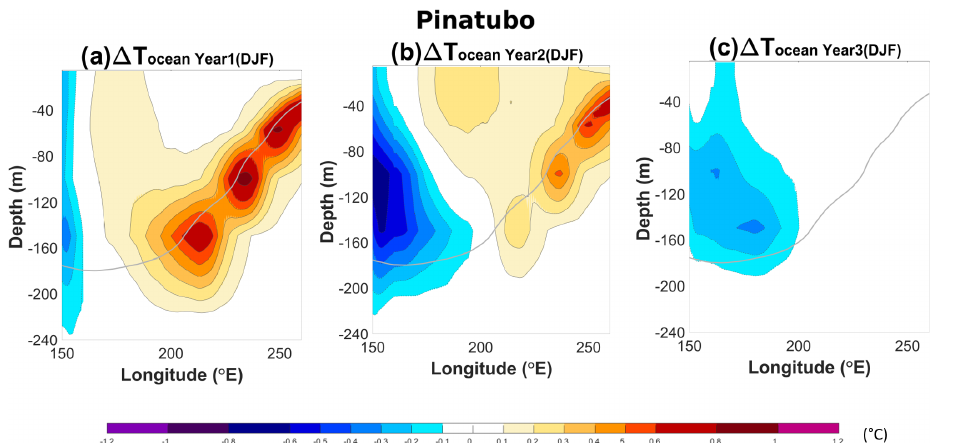
Figure A16. Ensemble mean changes shown for a transect in the equatorial Pacific (averaged 5 ◦ N–5 ◦ S) of the ocean temperature (shadings) between the volcano case and the climatology for each of the following three winter seasons (DJF) after the Pinatubo eruption. Contours show the SST anomalies following the colour bar scale (solid lines for positive anomalies and dashed lines for negative anomalies; the 0 line is omitted). The bold grey line shows the climatological thermocline depth (as defined using the 20 ◦ C isotherm). This is shown for 100 ensemble